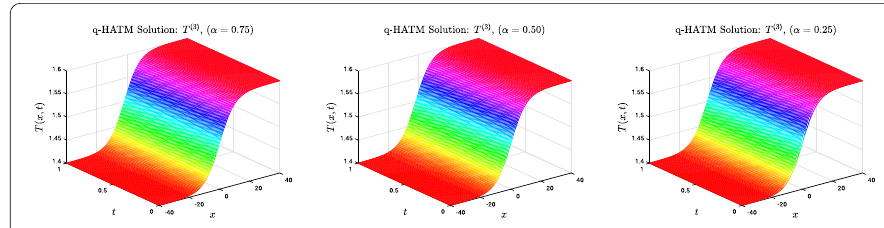
Figure 6 q-HATM T (3) -solution with different α when (cid:2) = –1, k = η = 0.1, r = –1.5, p = 1.5, and n = 1 for Example